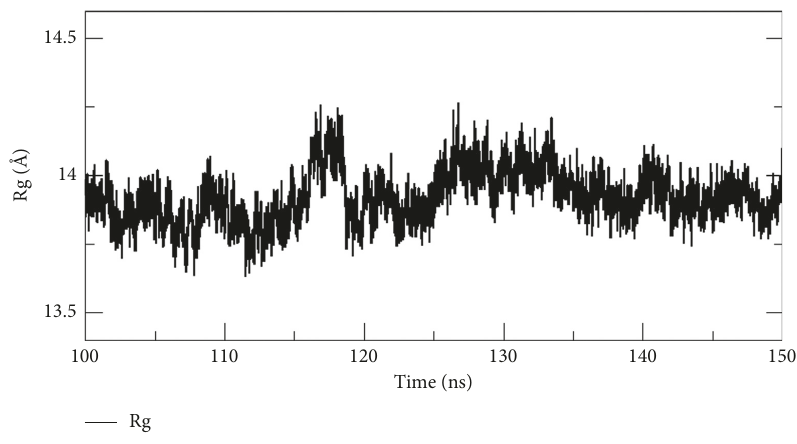
Figure 4: Gyration radius.